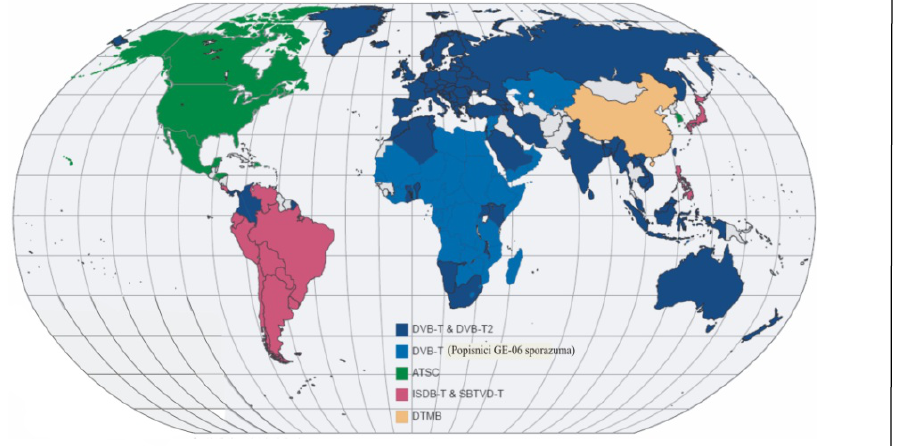
Figure 3 – Current distribution of broadcast technologies in the world U tabeli 2 je dat pregled nekih osnovnih parametara razli č itih tehno- logija za radio-difuznu mobilnu